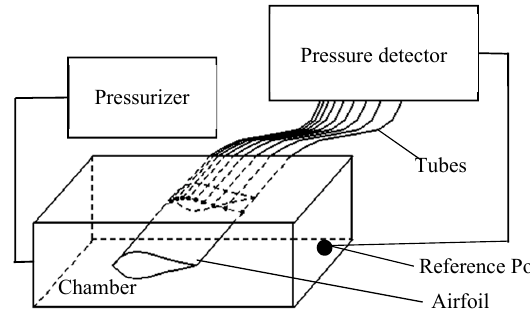
Figure 8. Calibration of dynamic response in air of tubing.